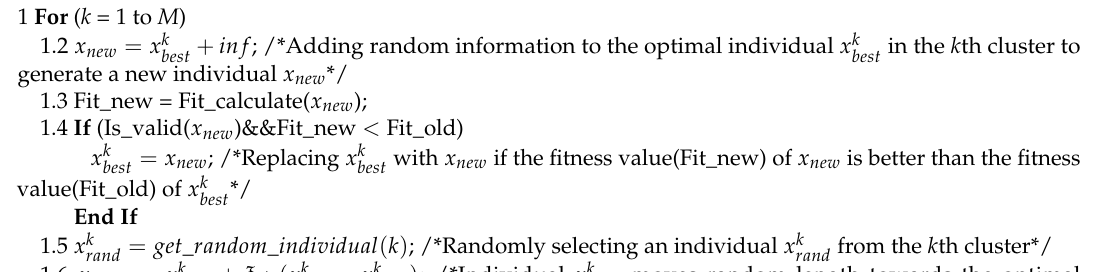
Algorithm 3. Improved updating strategy